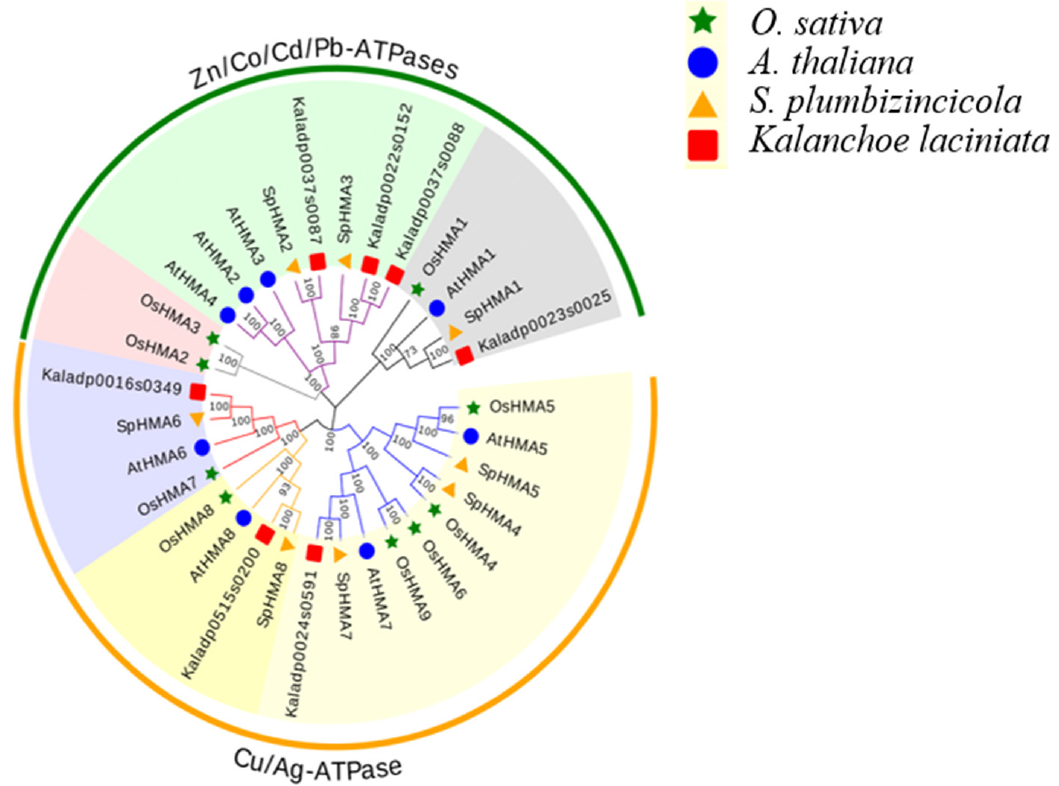
Figure 2. Phylogenetic analysis of HMA genes among A. thaliana , O. sativa , K. laciniata , S. plumbizincicola. MEGA 7.0 was used to construct a maximum likelihood (ML) phylogenetic tree with 1000 bootstrap replicates.